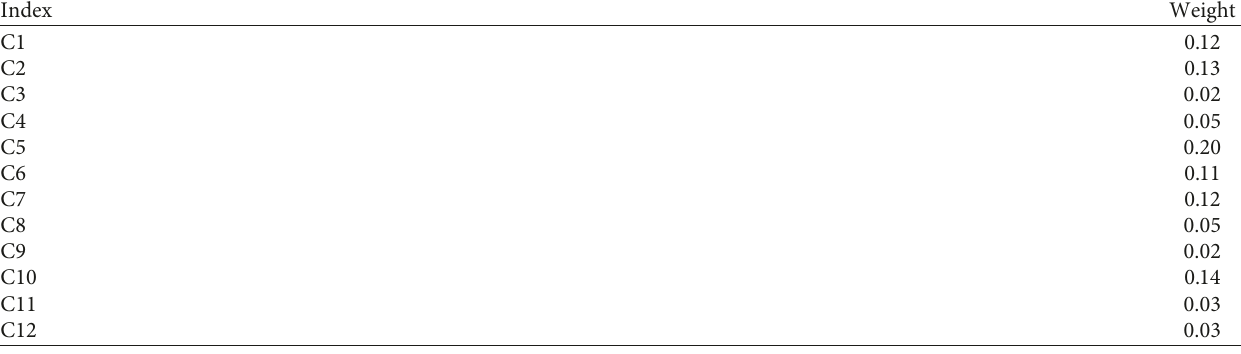
Table 2: Weight distribution of each indicator.